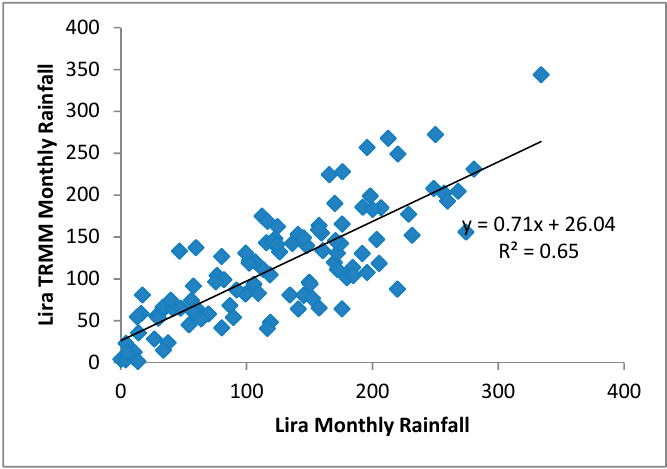
Figure 2. Correlation of TRMM and observed rainfall data for Lira.